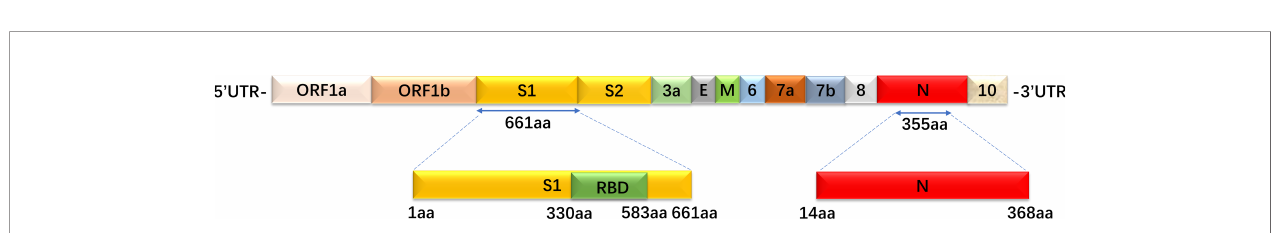
FIGURE 1 | Highly variable neutralizing antibody titers of 57 convalescent plasmas from COVID-19 patients discharged in Zhejiang province from January to March in 2020. Plotted by IC 50 mean with SD. Neutralizing antibody in 5 convalescent plasma samples were